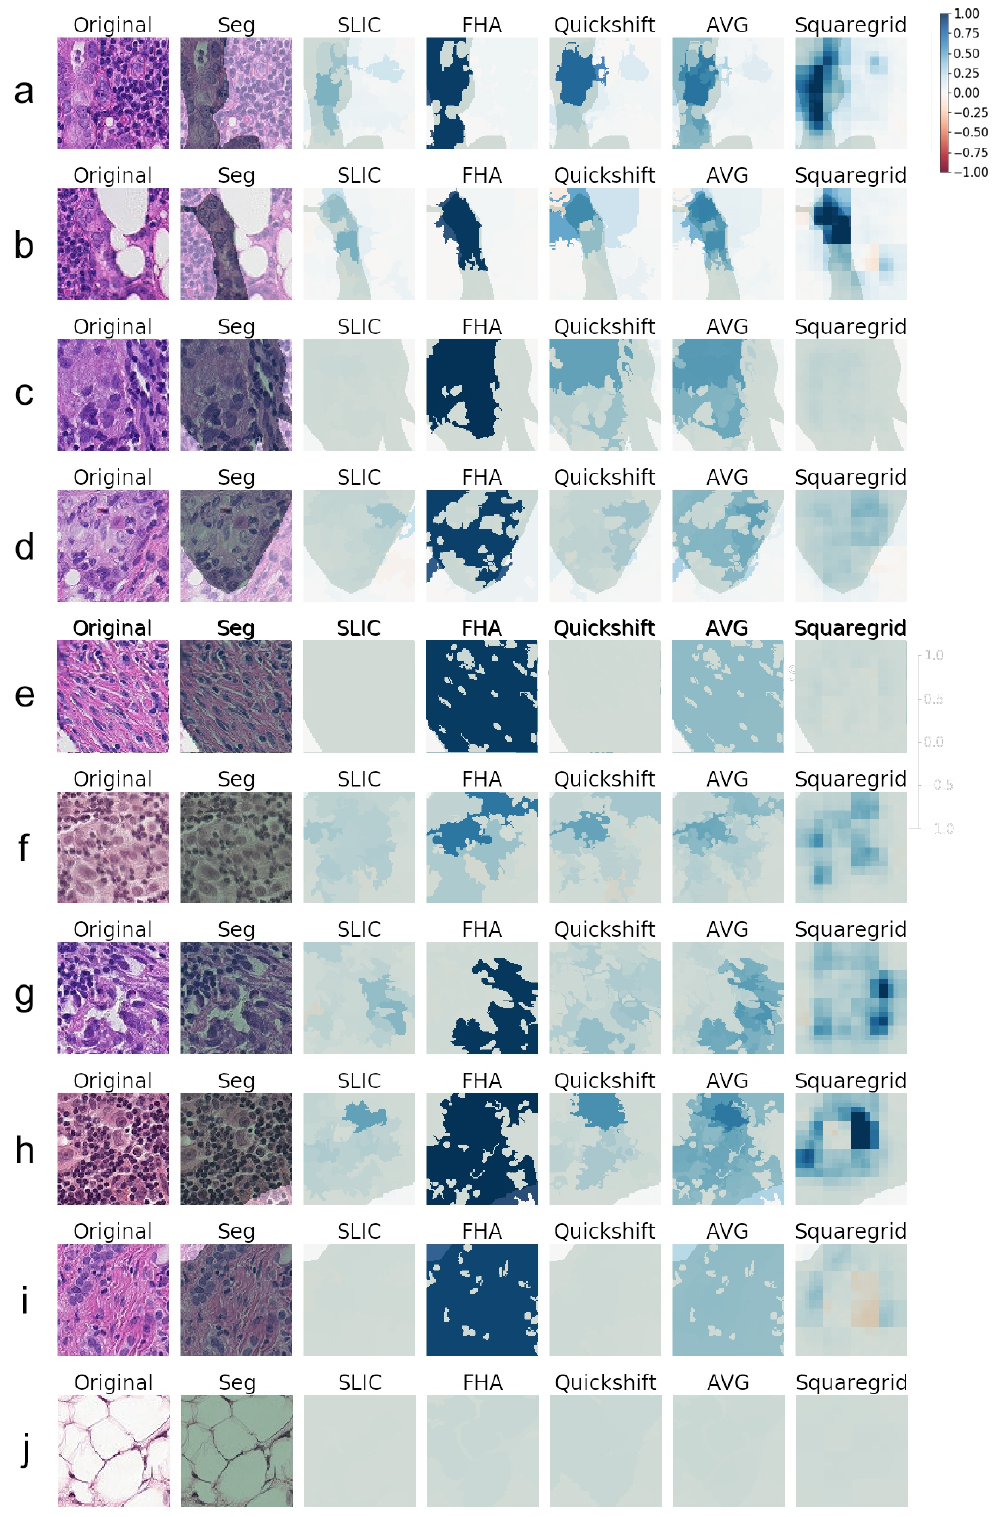
Figure 6. ( a – j ) Explanations generated for several images correctly predicted as Class 1 (true positives) by Model1. Medical Segmentation (Seg) in transparent green. All heat maps used the same red-blue color scale with the same limits of [ − 1,1]. AVG corresponds to the arithmetic average of the SLIC, FHA, and quickshift heat